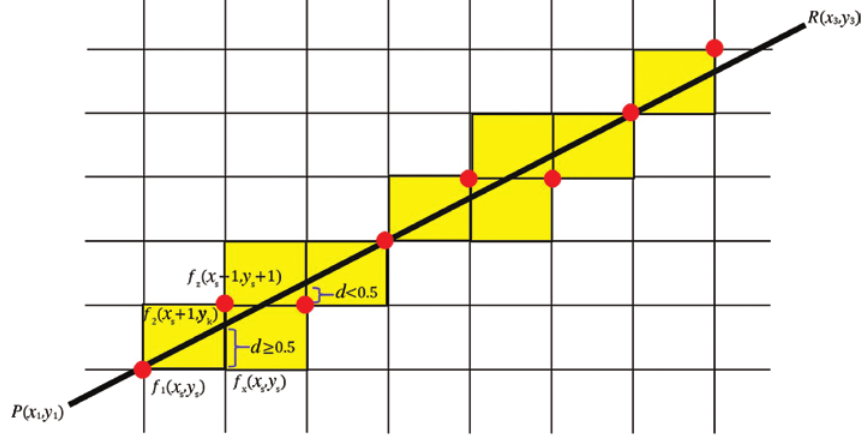
Figure 7: Delineation of Bresenham Method Pixel